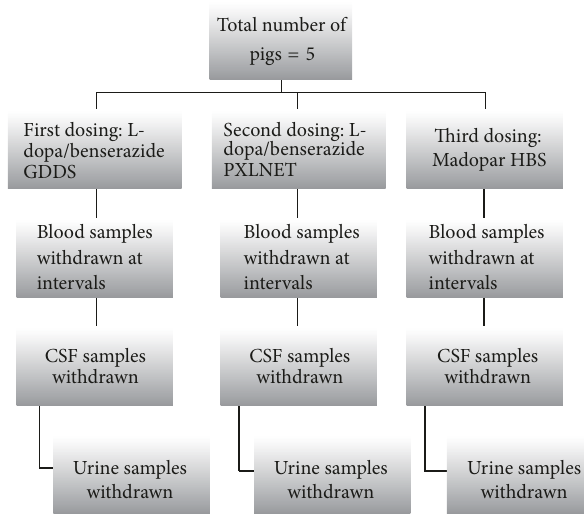
Figure 1: Flow diagram detailing in vivo animal studies for three drug delivery